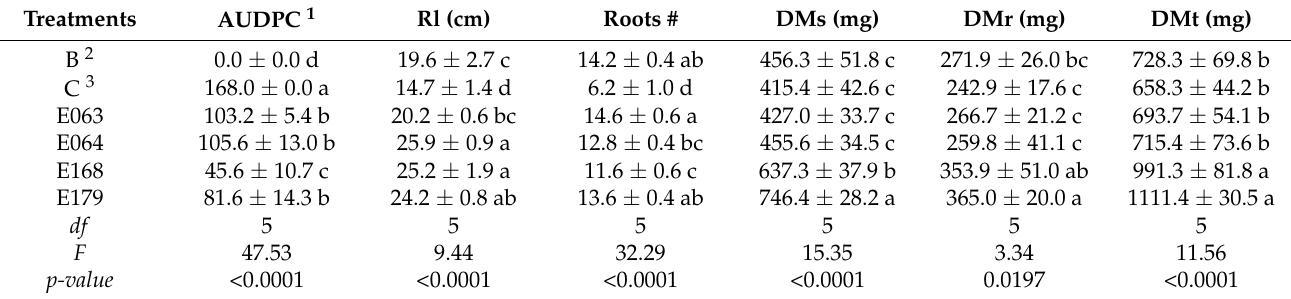
Table 3. Effect of the post-emergence application of extracts of endophytes on the disease severity, expressed in terms of the area under the disease progress curve (AUDPC), and different growth traits (Rl: root length; number of roots; DMs: shoot dry matter weight; DMr: root dry matter weight; DMt: total dry matter weight) in Lupinus plants inoculated with Phytophthora cinnamomi under greenhouse conditions. Values are expressed as mean ( n = 5) ± standard error. A summary of ANOVAs is also given at the bottom of the Table ( df : degree of freedom; F : F -value; and p